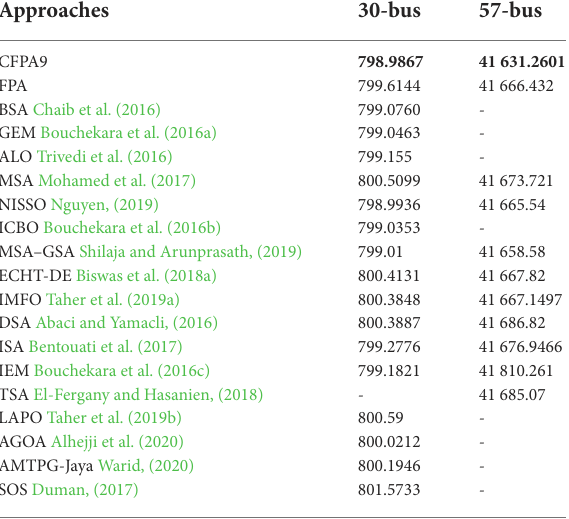
TABLE 9 Comparison analysis of 30-bus and 57-bus test system case 1 and case 3.